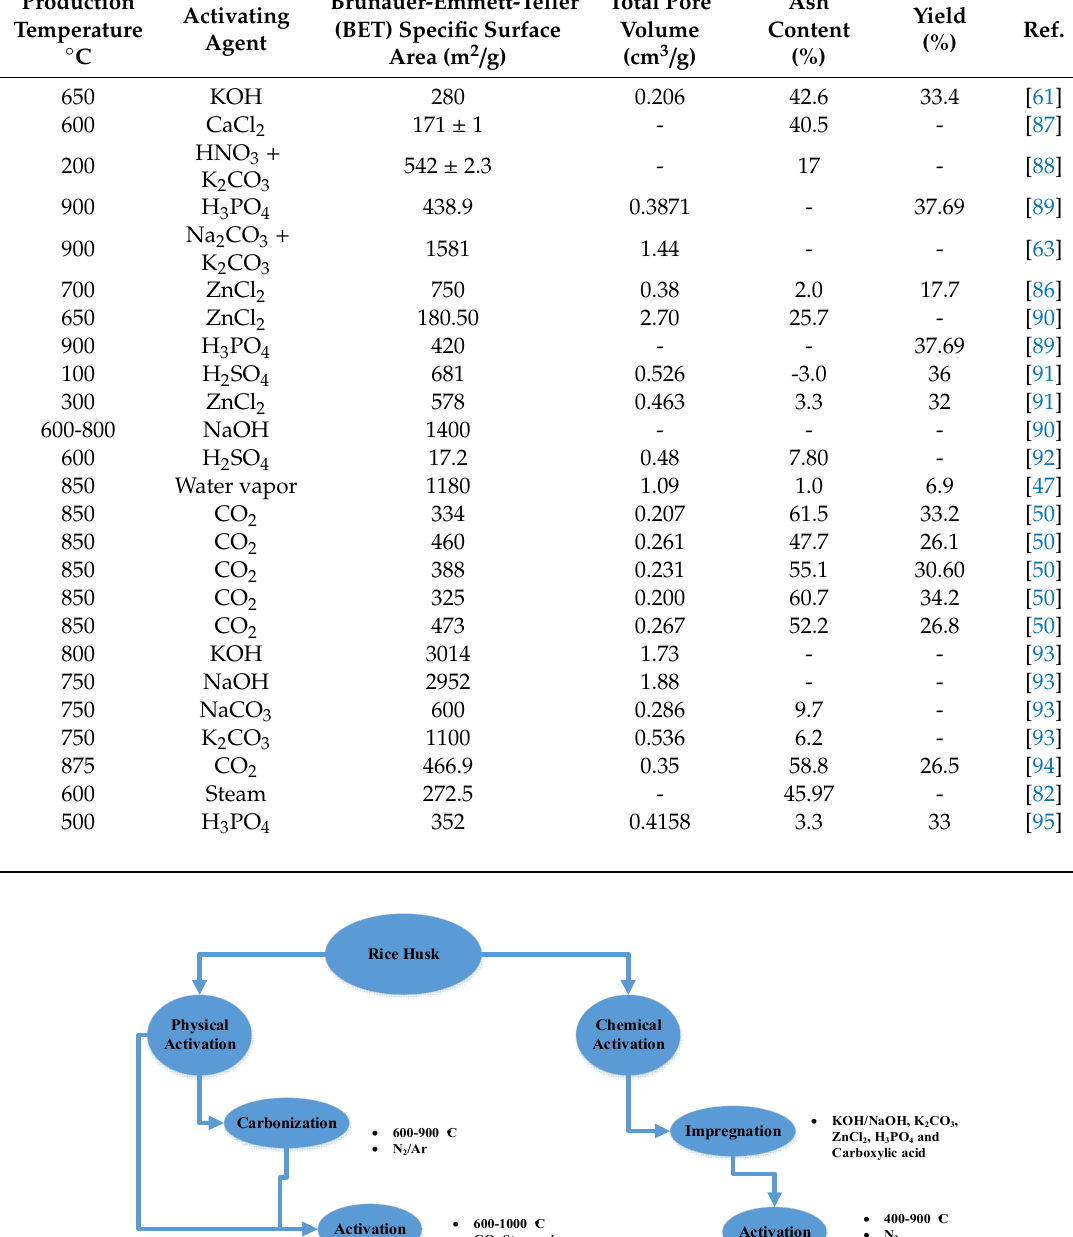
Table 3. Physiochemical characteristics of the rice husk (RH)-derived activated carbon (AC).